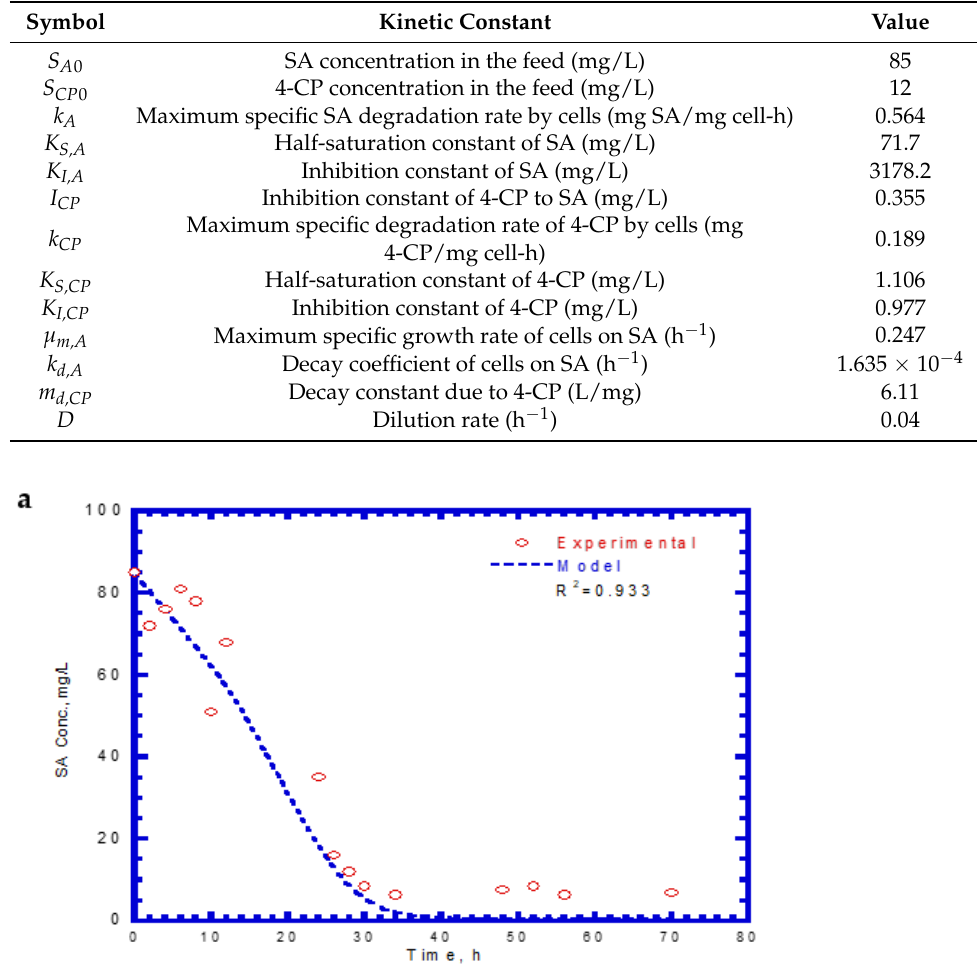
Table 2. Kinetic constants of SA and 4-CP for the chemostat model input.